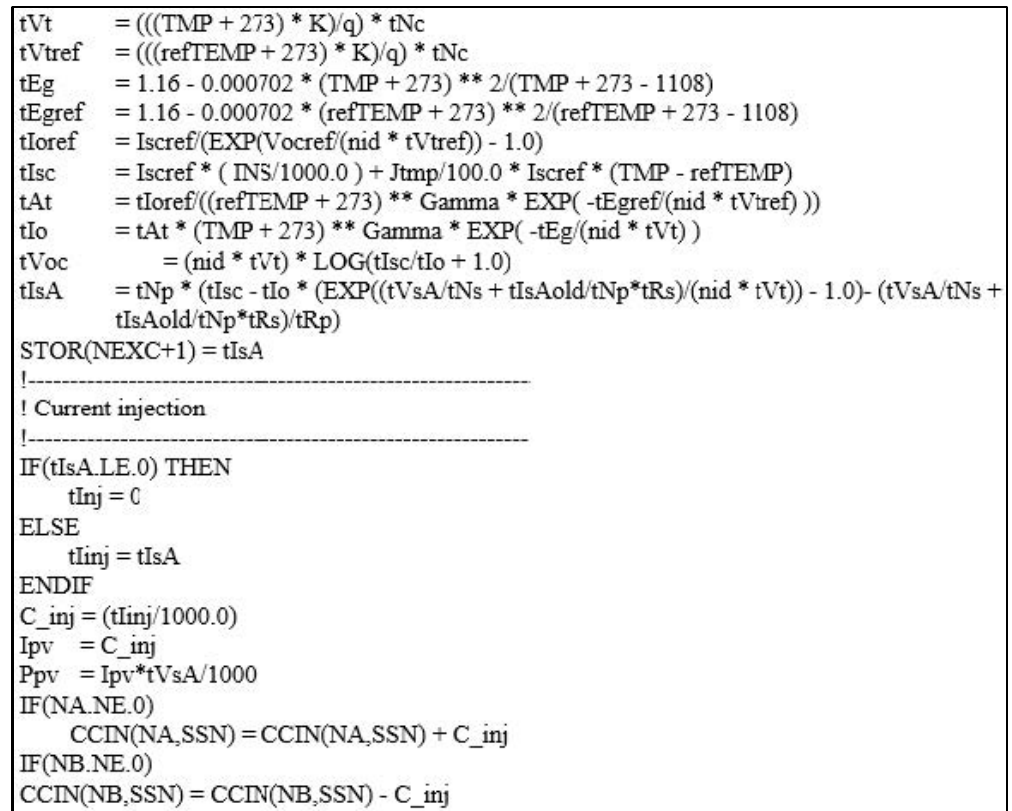
Figure 6. Fortran code for PV module characteristics and terminal current.